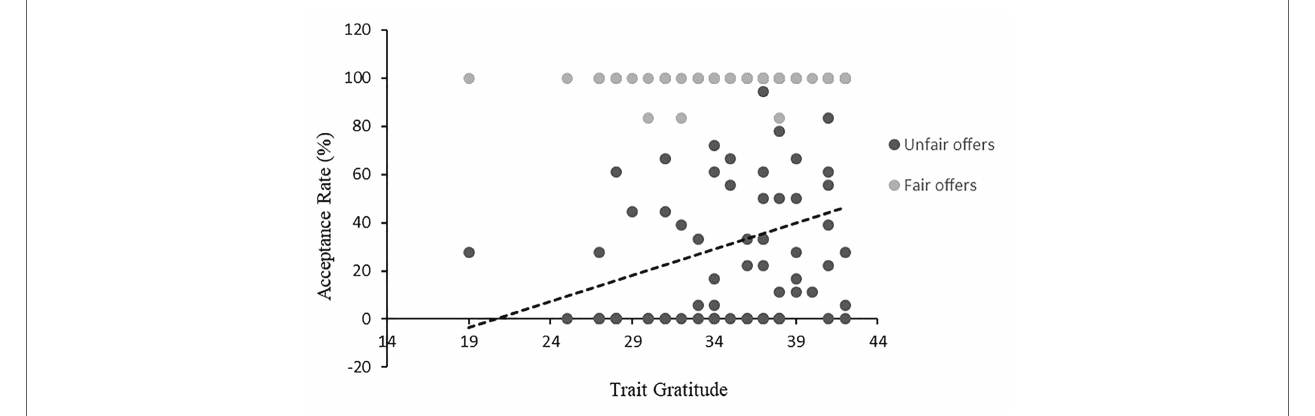
FIGURE 3 | Percentage of acceptance of fair ( r = 0.09, p = 0.49 for $5-$5) and unfair ( r = 0.32, p < 0.01 for unfair offers averaging $7-$3, $8-$2, $9-$1) offers as a function of trait